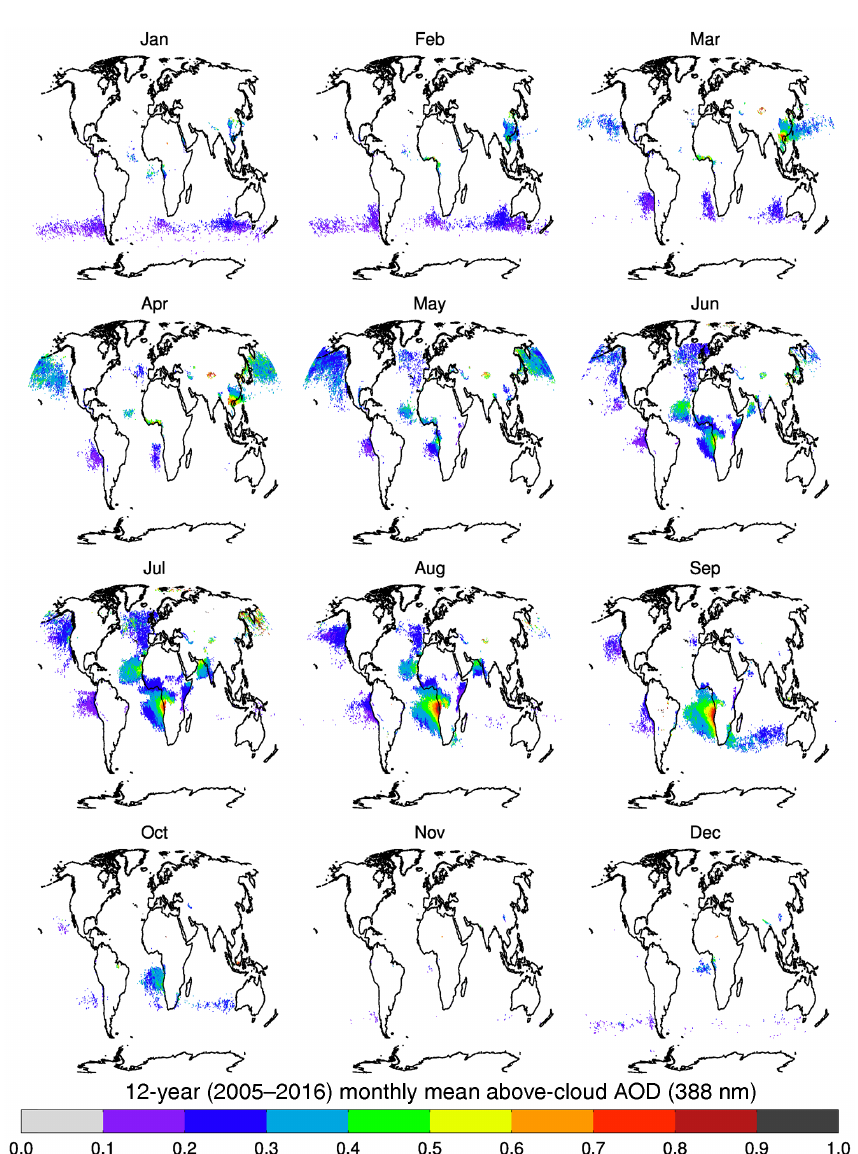
Figure 8. Global distribution of monthly mean above-cloud AOD (388nm) deduced from the 12-year (2005–2016) OMI